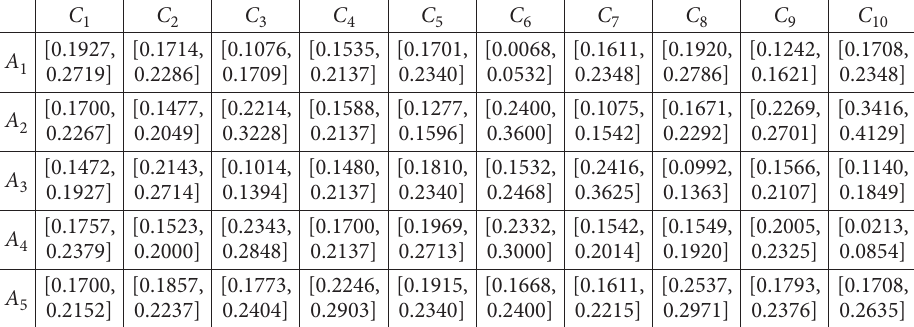
Table 9. Normalized grey decision making matrix C 1 C 2